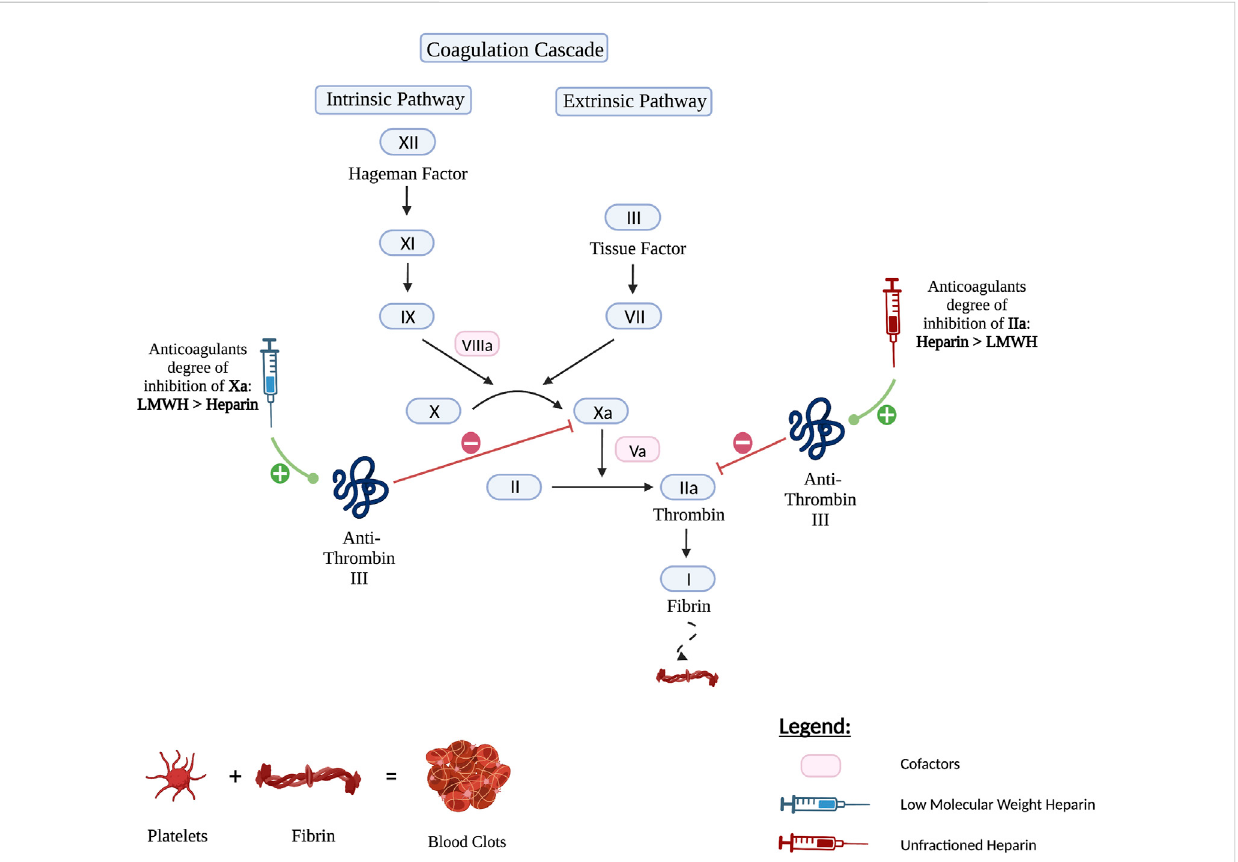
FIGURE 1 The mechanism of action of LMWH versus Unfractionated Heparin. Both Heparin and LMWH possess an anti-coagulant therapeutic effect. They exerttheiractivitybyupregulatinganti-thrombinIIIwhichinturninhibitsfactors IIaalsoknownasthrombinandfactorXa.However,Heparinhasahigher anticoagulant degree of inhibition of factor IIa than LMWH and therefore inhibits factor IIa more strongly. As for LMWH, it has a higher anticoagulant degree of inhibition of factor Xa and hence inhibits factor Xa more